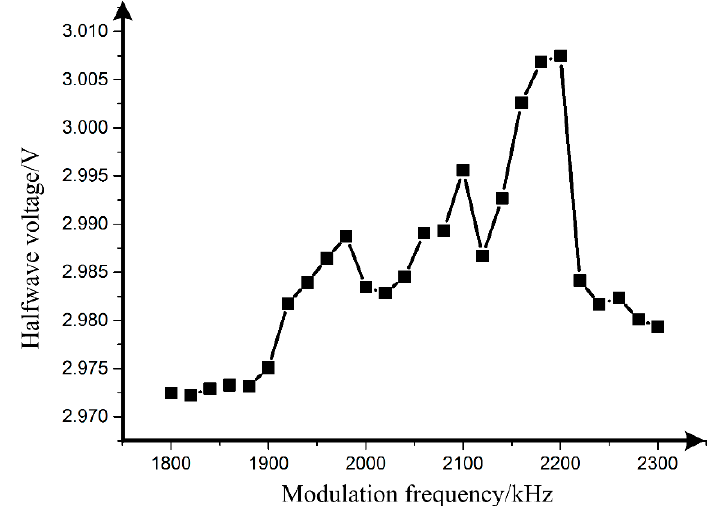
Figure 4. Measurement result of the frequency-dependent halfwave voltage.